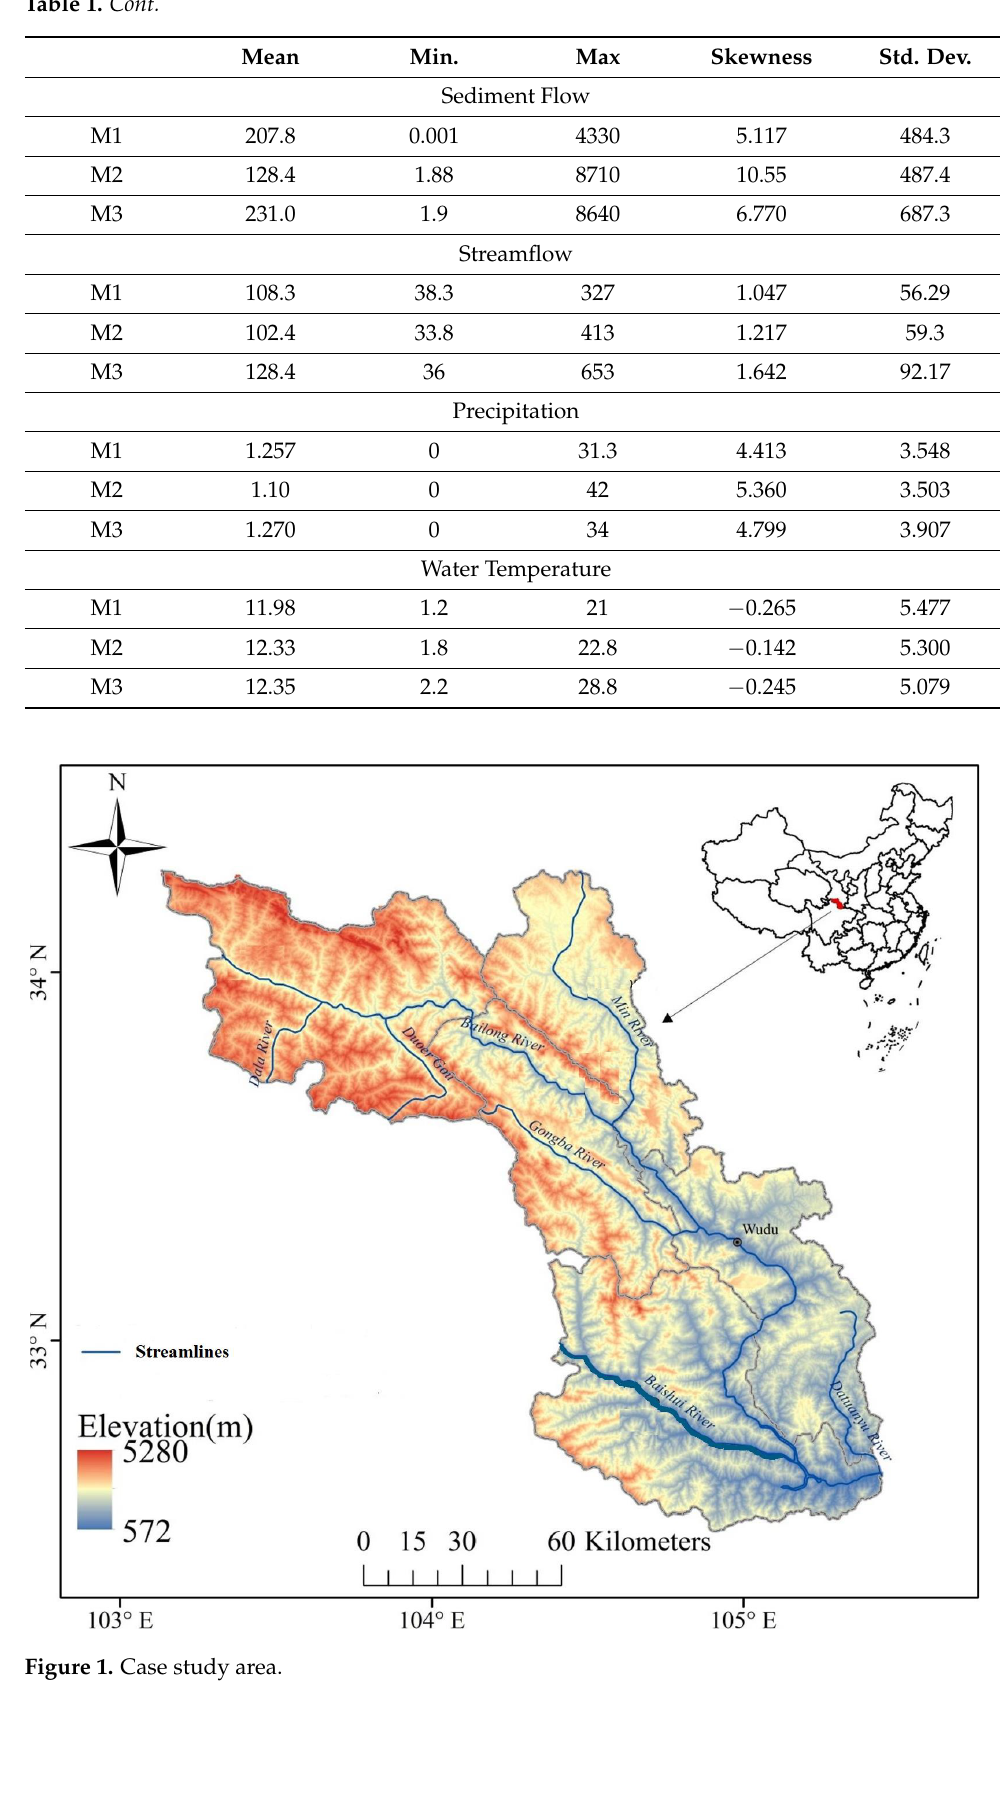
Figure 1. Case study area.